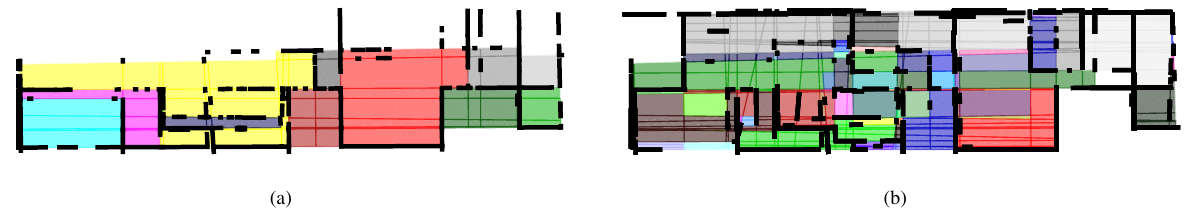
Figure 11. Dataset Fire Brigade : floor plans obtained with (a) the proposed method and (b) the method by (Magri and Fusiello, 2018). This figure is best viewed in